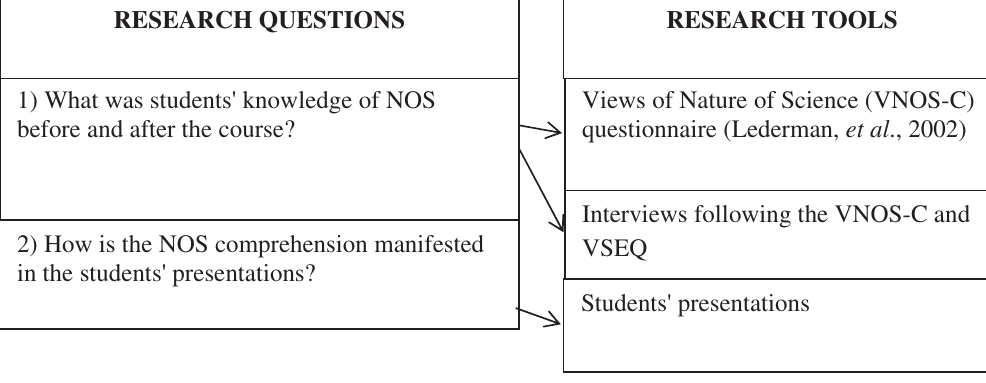
FIG. 1. Research tools for research questions 1 and